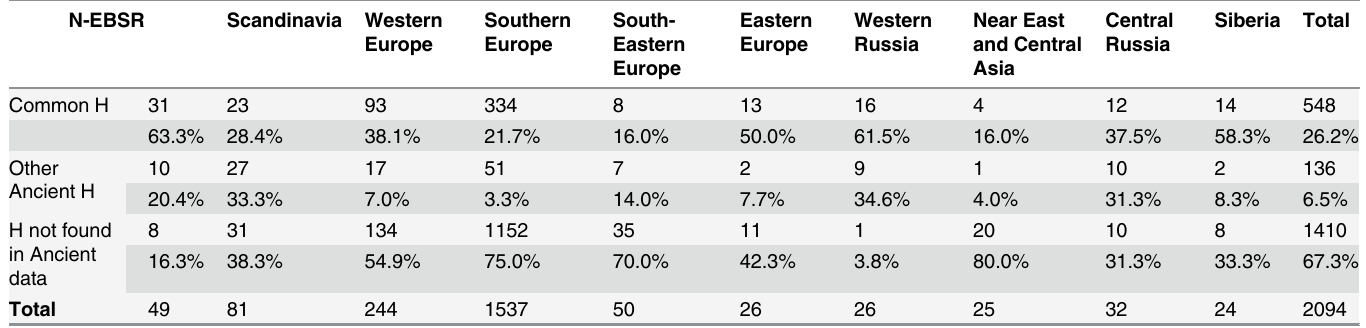
Figures represent the count and percentage of modern cattle data from ten geographical regions grouped in three haplotype (H) groups according to the appearance of the haplotypes in ancient N-EBSR data: The most common 245 bp haplotype (Common H), other ancient haplotypes found in